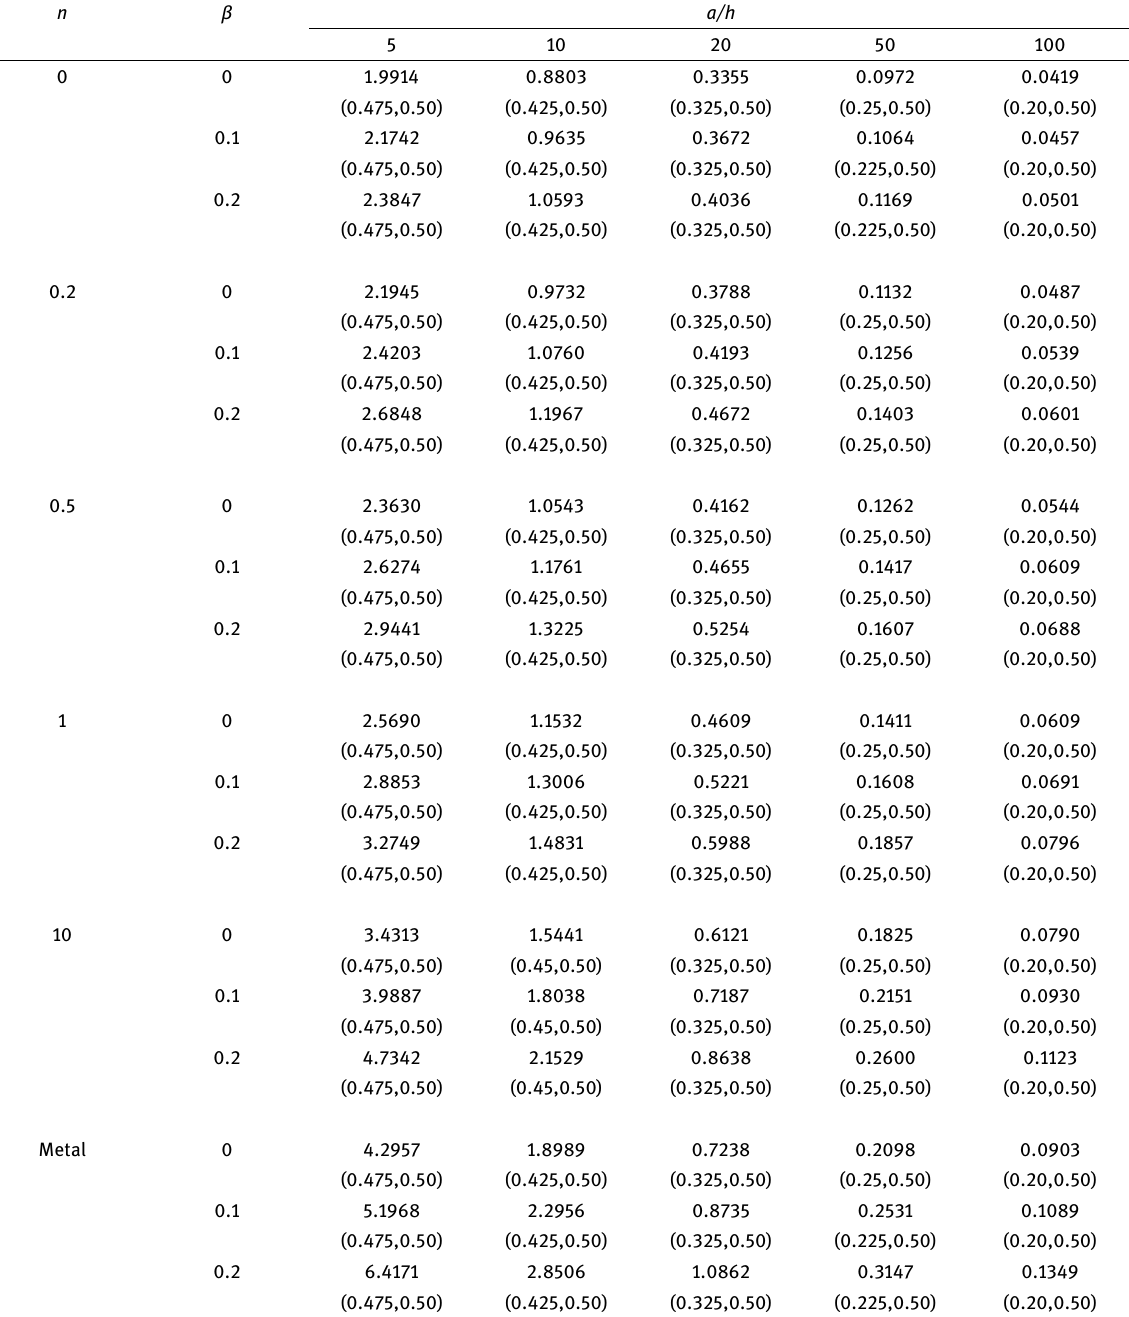
Table 6: Variation of non-dimensional deflection of simply supported FGM porous conoidal shell subjected to sin-sin